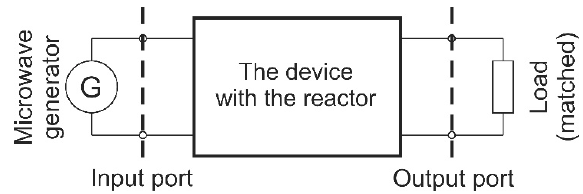
Figure 6. The proposed model of the microwave-powered microreactor.